Question: Looking at the figure, what chart type is it?
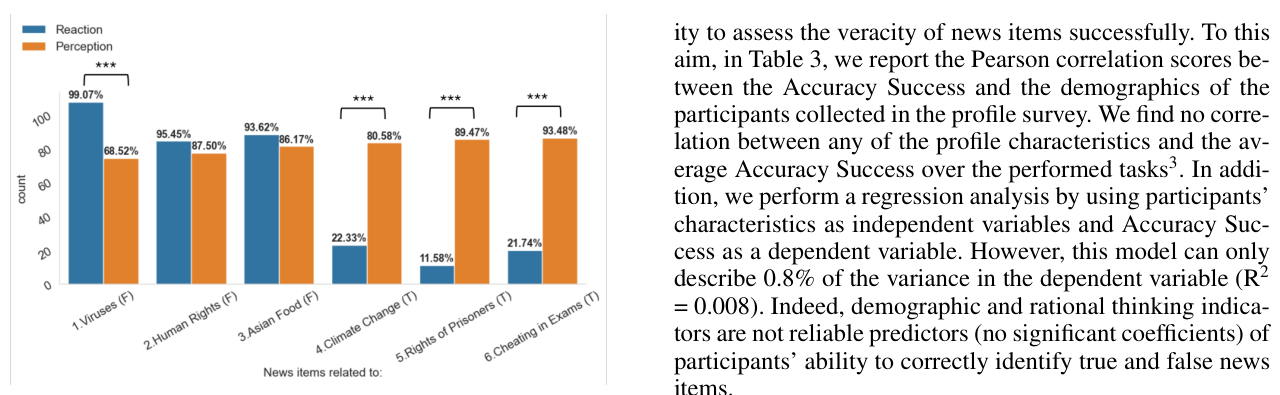
Answer: bar